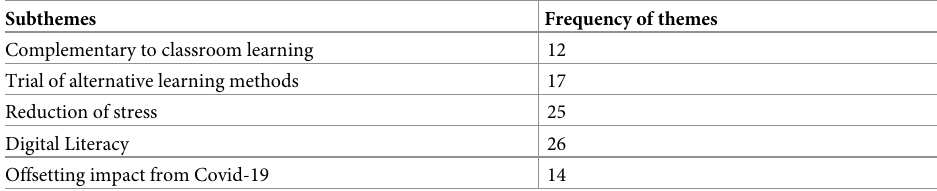
Table 5. Subthemes of strength for informal